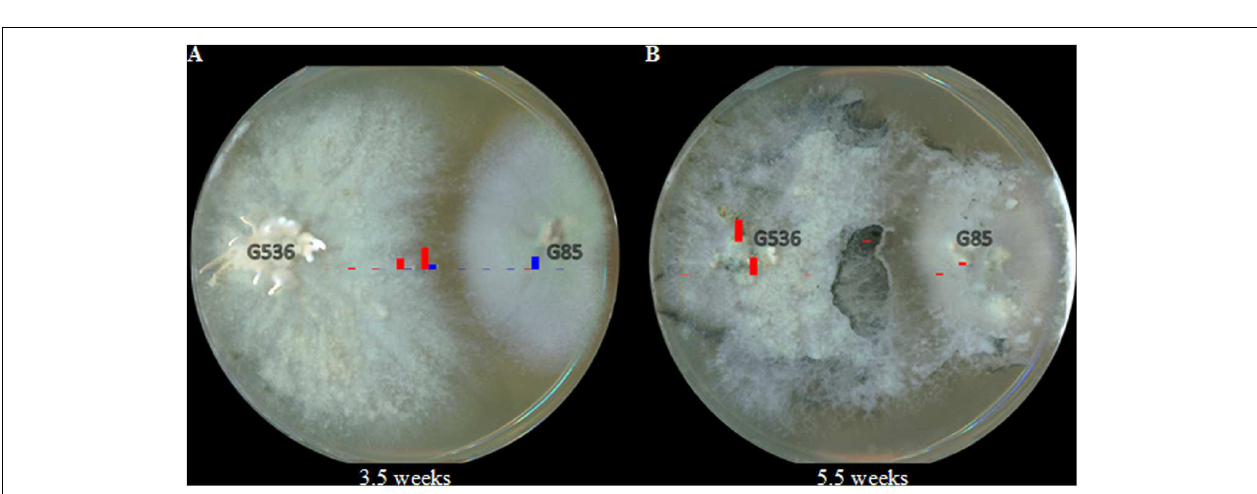
FIGURE 7 | The spatial distribution of the (A) blue and (B) purple groups of polyhydroxyanthraquinones on fungal isolates of P. restrictum (G85) while grown in co-culture with X. cubensis (G536) at 2.5 weeks. The color coding (blue and purple) corresponds to the structures in Figure 1 . Each circle represents a sampled location. The polyhydroxyanthraquinones were most intense where the blue or purple circles were brightest. The bottom bar indicates the relative amount of signal as measured via mass spectrometry.